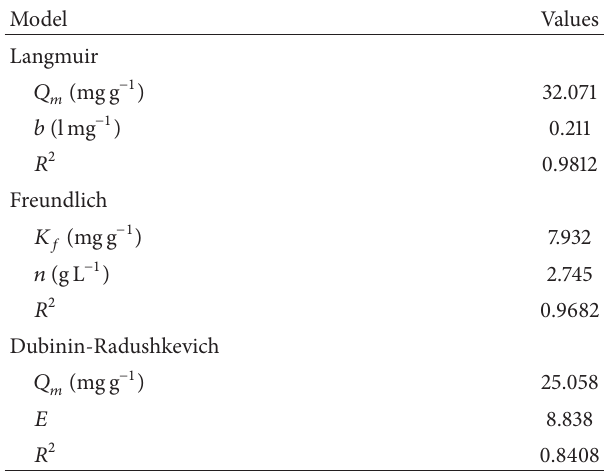
Table 3: Isotherm parameters for Cd(II) biosorption by